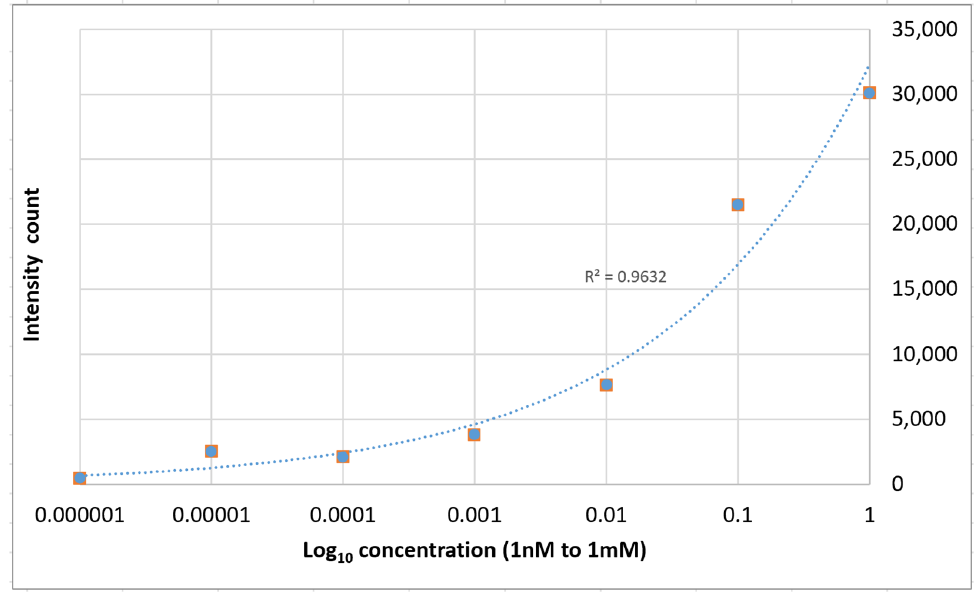
Figure 10. 1364 cm − 1 Raman signal strength vs. Rhodamine 6G concentration on PETE-1 SERS.